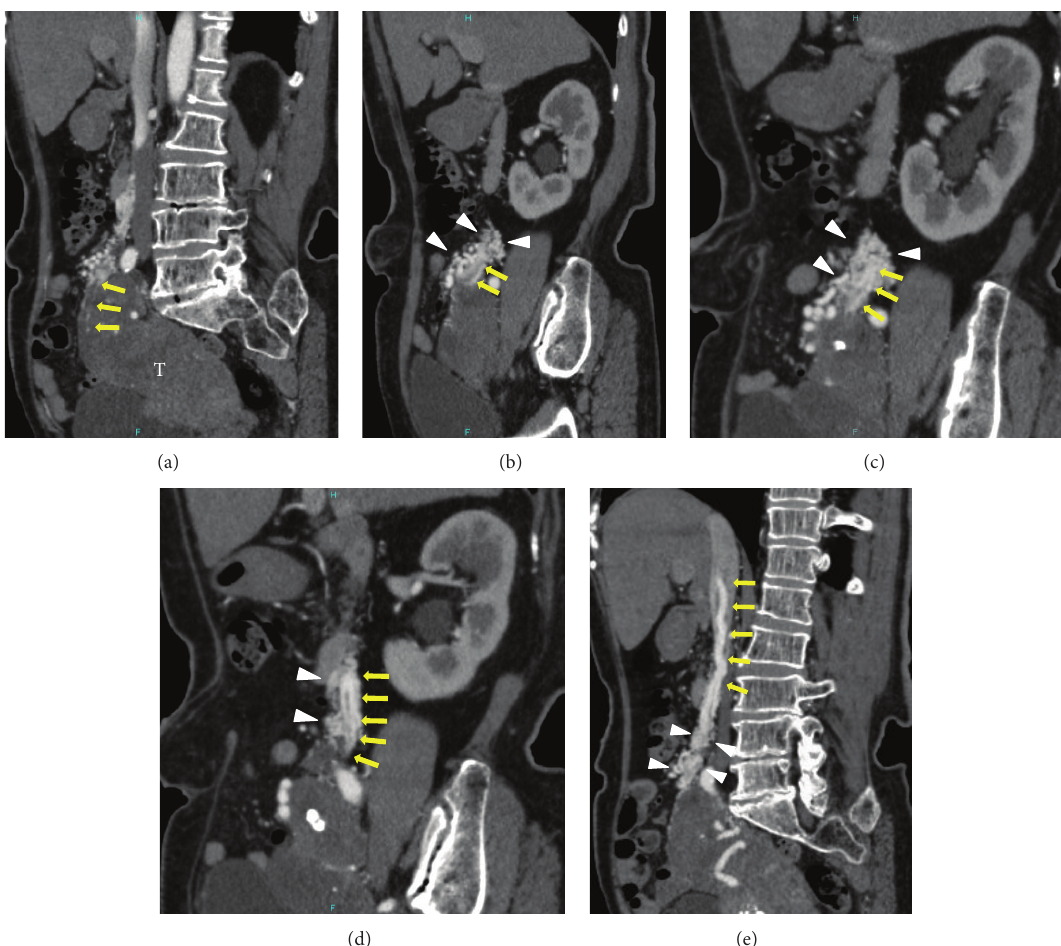
Figure 2: (a) Multiplanar reconstruction (MPR) images along the tumor arteries allowed for identification of the origin of the intravascular component (arrows) arising from the uterine tumor (T). ((b)–(e)) A plexus of small arteries, which comprised complex vascular formations (arrowheads) originating from the right ovarian artery, the right subcostal artery, and the right uterine artery, surrounded tumor arteries (arrows) along the route of the right ovarian vein and caused the diameter of tumor arteries to expand by communicating with each other at many